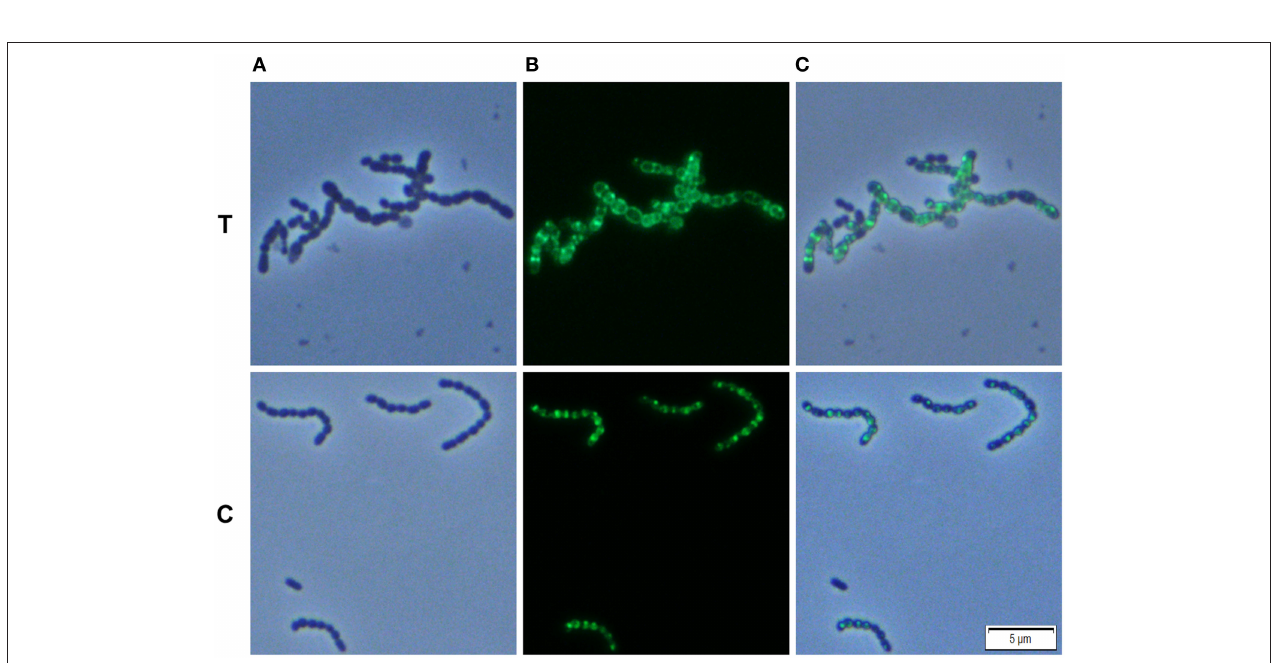
FIGURE 4 | Effect of Carolacton treatment on the localization of the cell division protein PknB in S. mutans UA159. The chromosomal (D)-xylose inducible GFP + -PknB reporter strain MR43 was grown in buffered (75 mM and pH 6.5) complex THBY medium to the early exponential growth phase (OD 600 = 0.2). Cells were treated with and without 5.3 µ M Carolacton and GFP + -PknB expression was induced for all samples (treated/untreated) with 1.5% D-xylose. 3 h post induction cells were harvested, washed and analyzed under the fluorescence microscope. Phase contrast (column A ), fluorescence (column B ), and overlay images (column C ) of Carolacton treated (upper panel T ) and untreated control cells (lower panel C ) are presented.